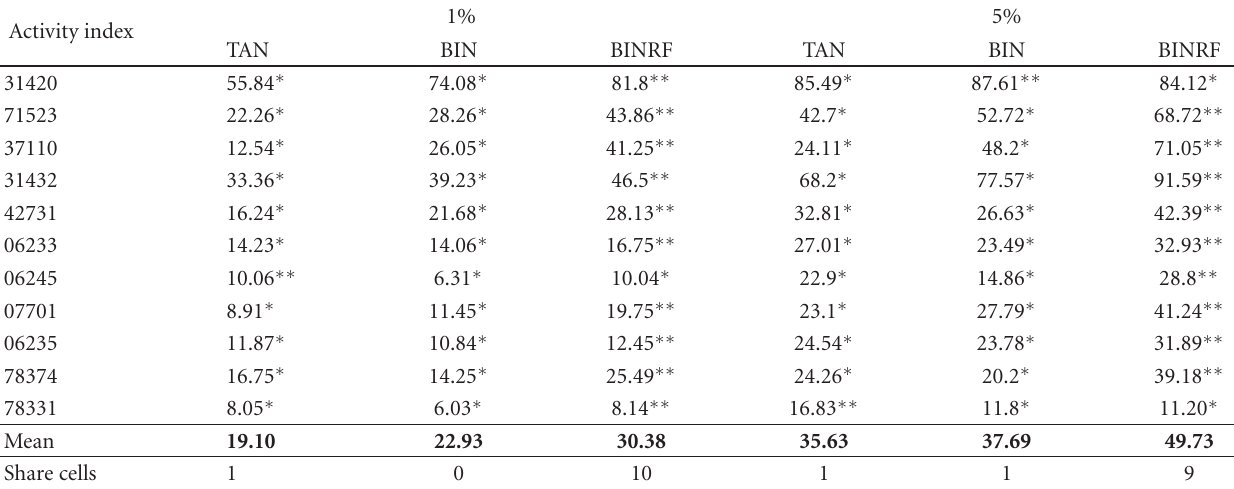
Table 5: The recall is calculated using the top 1% and top 5% of the DS2 data sets when ranked using the TAN, BIN, and BINRF. Activity